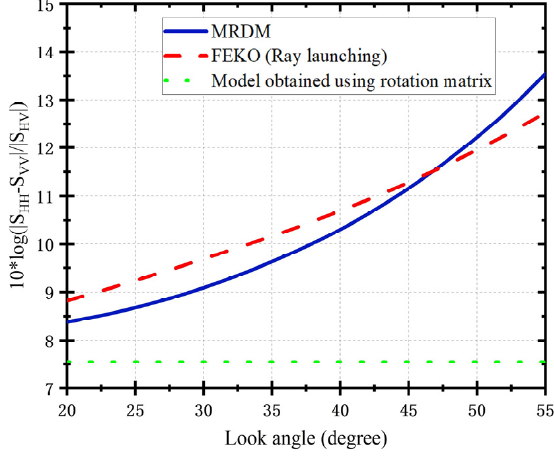
Figure 4. Comparison of parametric scattering model with different look angles.